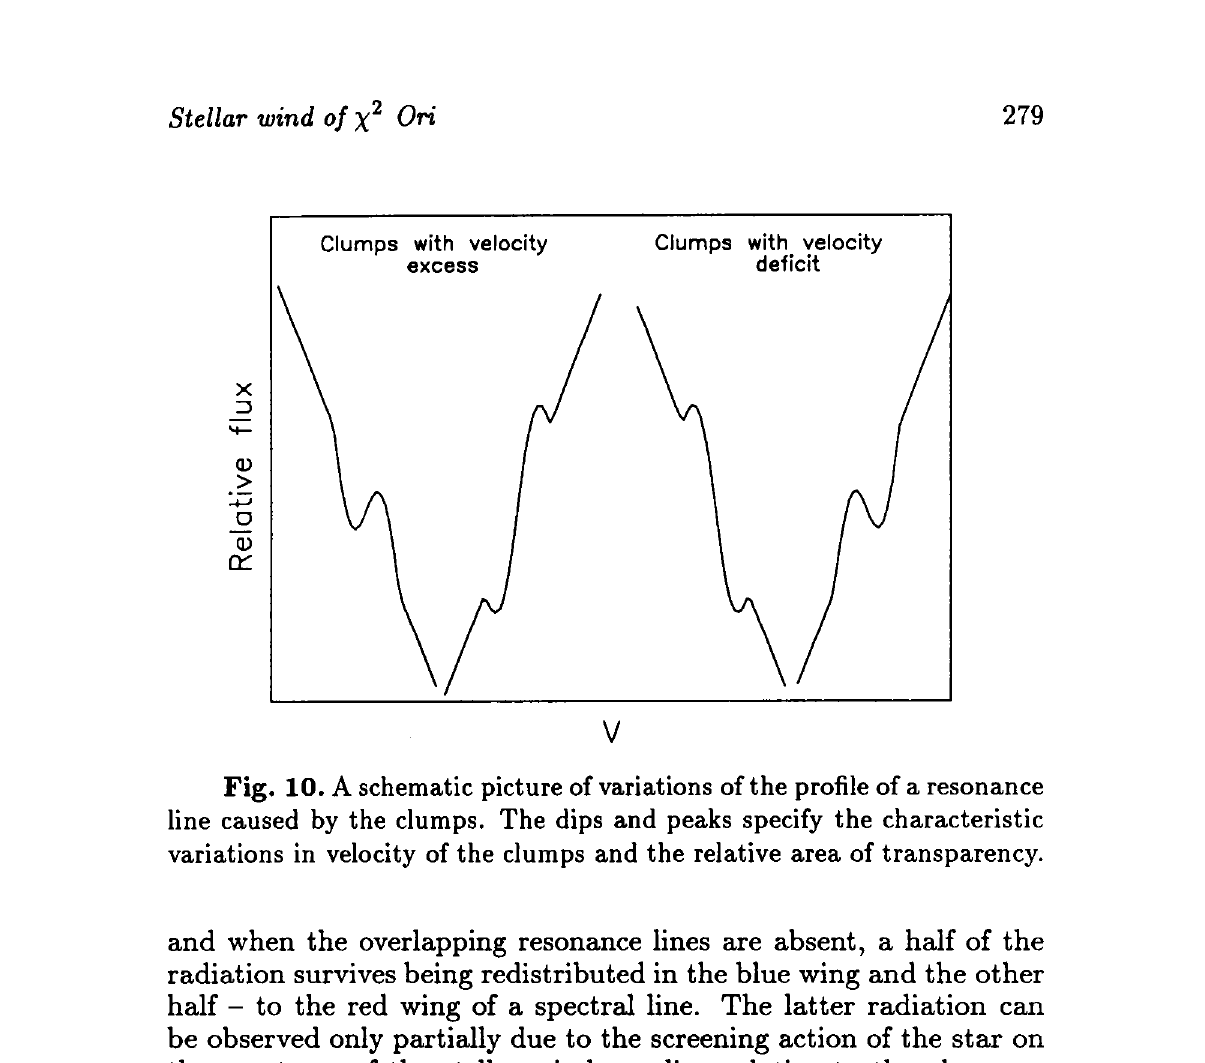
Fig. 10. A schematic picture of variations of the profile of a resonance line caused by the clumps. The dips and peaks specify the characteristic variations in velocity of the clumps and the relative area of transparency. and when the overlapping resonance lines are absent, a half of the radiation survives being redistributed in the blue wing and the other half - to the red wing of a spectral line. The latter radiation can be observed only partially due to the screening action of the star on the spectrum of the stellar wind receding relative to the